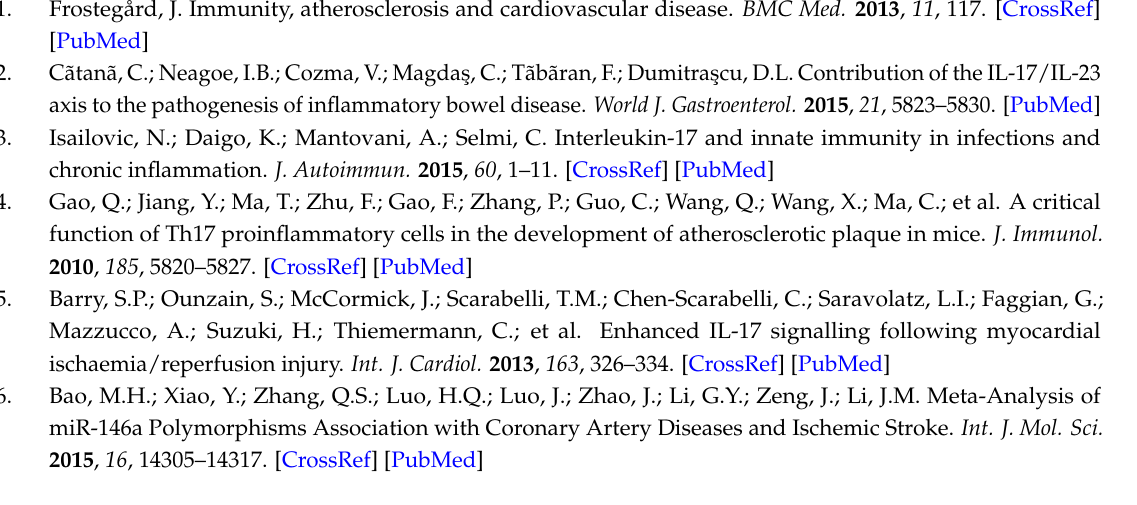
Figure S1: Forest plots of odds ratio for the association of IL-17A rs3819024 with risk of CAD, Figure S2: Forest plots of odds ratio for the association of IL-17A rs3819025 with risk of